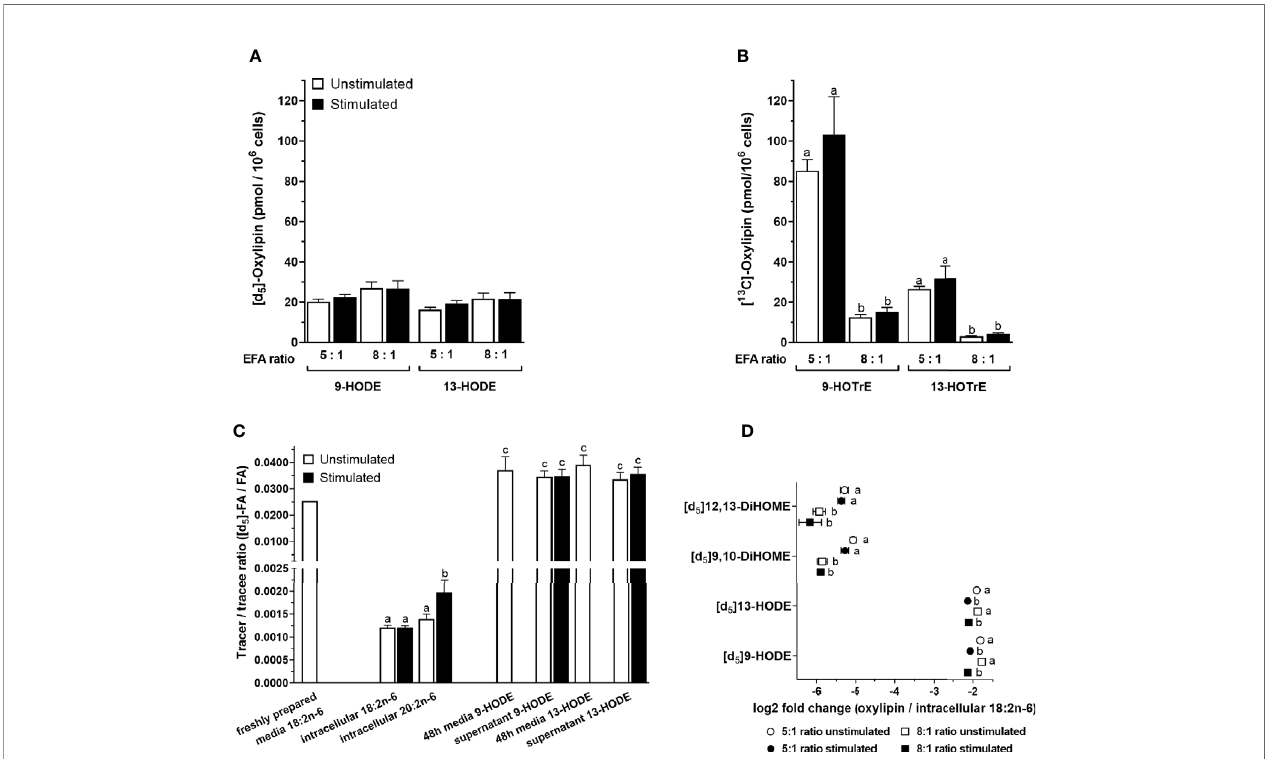
FIGURE 7 | The effect of essential fatty acid (EFA) ratio and mitogen stimulation on the concentrations of [ 13 C]18:3n-3 and [d 5 ]18:2n-6-derived oxylipins in culture supernatants after 48 h. LC-MS/MS analysis of labelled oxylipins in the supernatant from 48-h cultured human CD3 + T cells with an EFA ratio of either 5:1 or 8:1. Statistical analysis was performed in SPSS with two-way paired ANOVA (A, B, D) and (C) one-way ANOVA with Sidak ’ s unpaired multiple comparisons of individual oxylipins. Different letters mark signi fi cant changes between stimulation, EFA ratio, and tracer-to-tracee ratio within individual oxylipins. (A) Here, [d 5 ]18:2n-6 oxidation products 9- and 13-HODE were not altered by either EFA ratio or stimulation. (B) In addition, [1- 13 C]18:3n-3 oxidation products 9- and 13-HOTrE increase with higher 18:3n-3 concentration in 5:1 EFA ratio. (C) Tracer (labelled)-to-tracee (unlabelled) ratios were calculated for [d 5 ]HODE with an 8:1 ratio of 18:2n-6/18:3n-3 and compared to intracellular [d 5 ]18:2n-6, elongation product [d 5 ]20:2n-6, and non-enzymatically oxidised [d 5 ]HODE in freshly prepared and 48-h cultured cell media (in absence of T cells). (D) Here, [d 5 ]HODE and its oxidation product [d 5 ]DiHOME normalised to intracellular [d 5 ]18:2n-6 (GC-IRMS) are shown as log2 fold